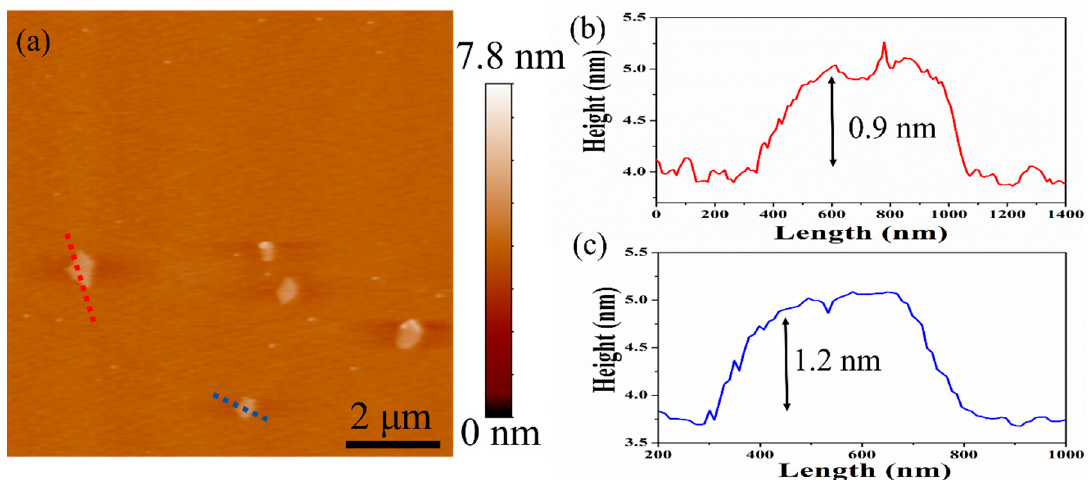
Figure 5. Atomic force microscopy (AFM) micrograph ( a ) and cartograms ( b , c ) of selected graphene sheets produced after 30 cycles of microfluidization.